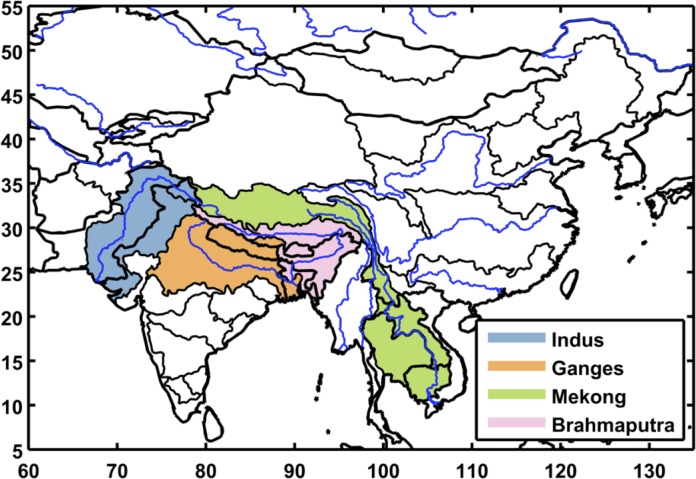
Map of major basins used to show the aggregate frequency distributions of water stress.